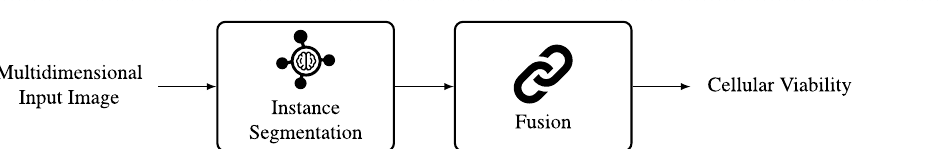
Figure 7. Automated Cellular Viability Analysis Pipeline. A multidimensional input image is processed with the presented approach of instance segmentation. A fusion step is required to obtain cellular